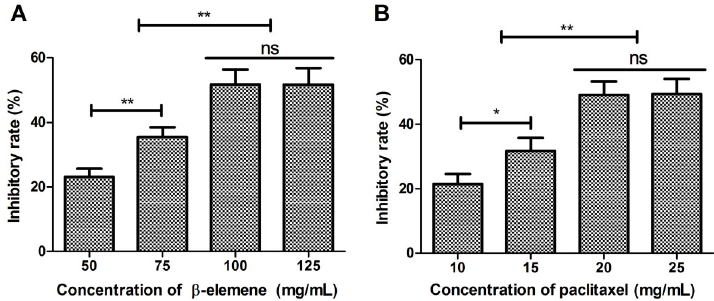
Figure 1. Dose-dependent assay of b -elemene ( A ) and paclitaxel ( B ) for SKOV3 cells growth. Data are reported as means ± SD. *P o 0.05, **P o 0.01 (ANOVA followed by Tukey ’ s multiple comparison post hoc test). ns: not signi fi cant.